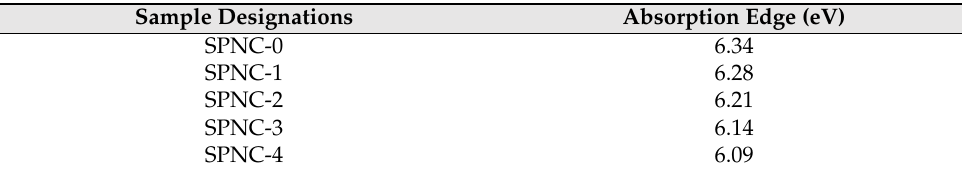
Table 3. Values of absorption edge for the whole prepared